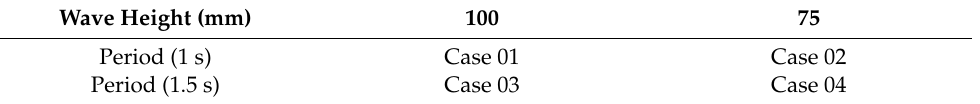
Table 2. Wave-period and wave-height-parameter table generated by the wave machine.